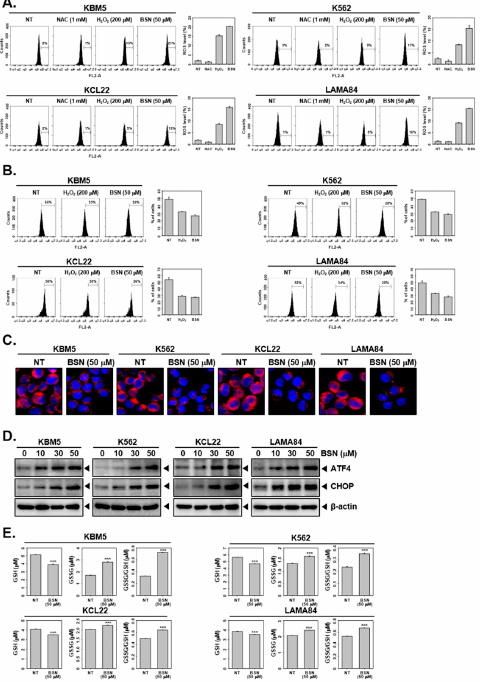
Figure 3. BSN induces ER stress in CML cells. ( A ) KBM5, K562, KCL22, and LAMA84 cells were treated with NAC (1 mM), H 2 O 2 (200 µ M), or BSN (50 µ M) for 12 h and ROS production was measured. ( B ) The cells were treated with H 2 O 2 (200 µ M) or BSN (50 µ M) for 24 h and mitochondrial membrane potential